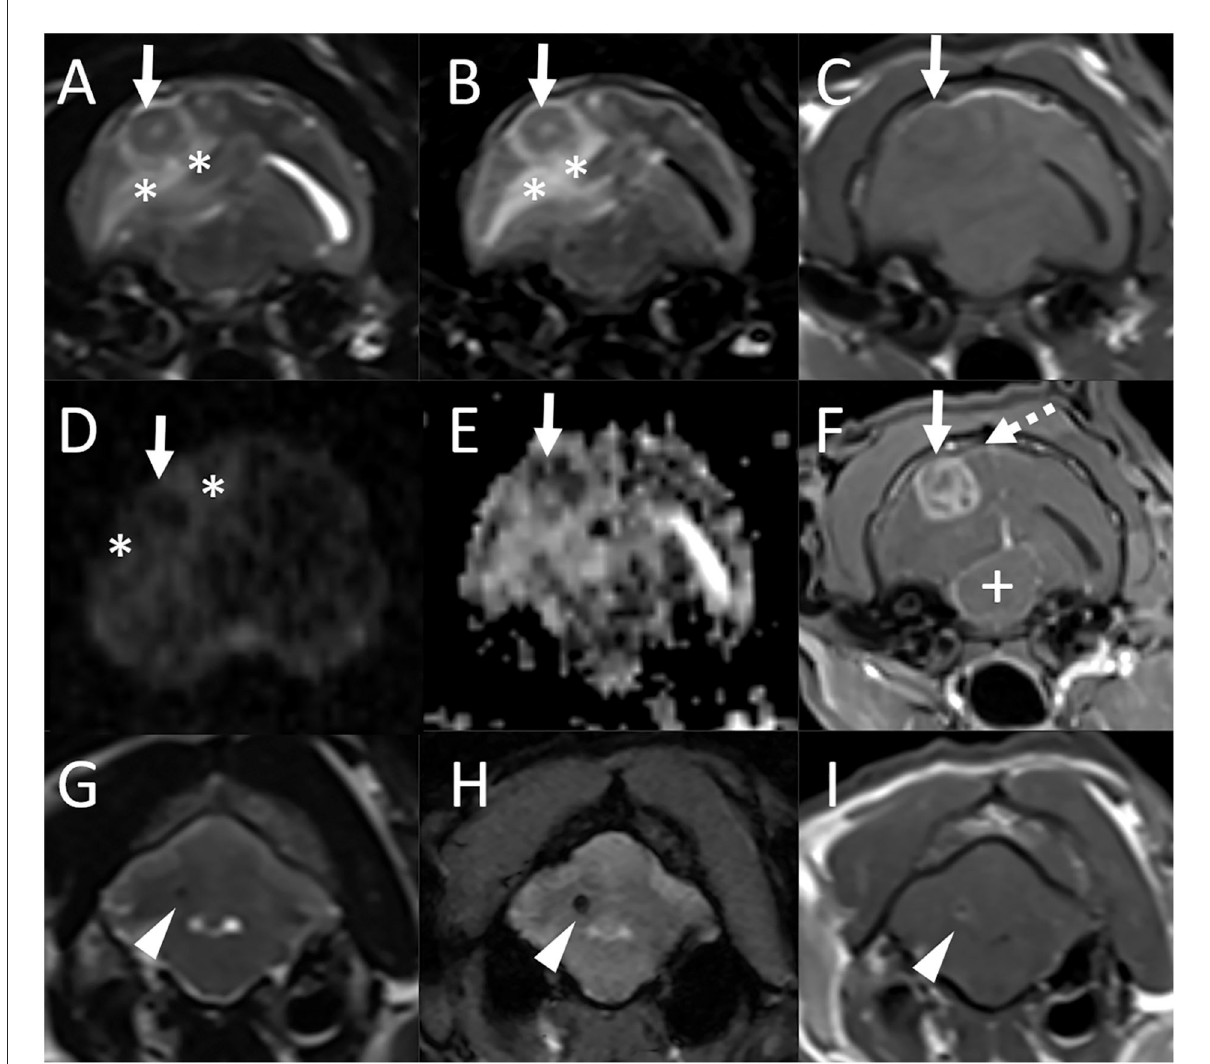
FIGURE2 Repeat MRI examination of the cat in Figure 1 (Case 1), 4 years and 4 months after the initial MRI study. Transverse T2-weighted (A) , T2-FLAIR (B) , T1-weighted (C) , diffusion-weighted imaging [DWI, (D) ] and corresponding apparent diffusion coefficient (ADC) map (E) , and postcontrast T1-weighted GRE with fat suppression (F) images at the level of the tympanic bullae and temporal lobes, and transverse T2-weighted (G) , T2*-weighted GRE (H) , and postcontrast T1-weighted (I) images at the level of the cerebellum. (A)–(F) There is a new finding of an ≈ 1.2 × 1.4cm ovoid mass in the right temporal lobe (solid arrows) which is predominantly T2, T2-FLAIR, and T1 isointense to gray matter with a small centrally located T2 hyperintense and T1 hypointense focus which does not suppress on T2-FLAIR [ (A)–(C) ]. The lesion is hypointense both on DWI and ADC maps [ (D) , (E) ]. There is marked perilesional T2 and FLAIR hyperintensity following the white matter tracts of the right cerebral hemisphere (*) with a moderate to marked mass effect characterized by compression of the right lateral ventricle, leftward midline shift, and compression of the mesencephalon ( + ). Following contrast medium administration, the mass displays marked heterogeneous contrast enhancement (F) . Mild focal pachymeningeal contrast enhancement is identified adjacent to the lesion (dashed arrow). An incidental small amount of fluid is noted within the bilateral tympanic bulla. (G)–(I) An ≈ 0.2-cm diameter well-defined T2 hypointense ovoid nodule is observed in the region of the previously seen cerebellar hemispheric lesion and is decreased in size from previous [ (G) , arrowhead]. This lesion is associated with a susceptibility artifact on T2*-weighted images (H) and has mild rim contrast enhancement (I) .